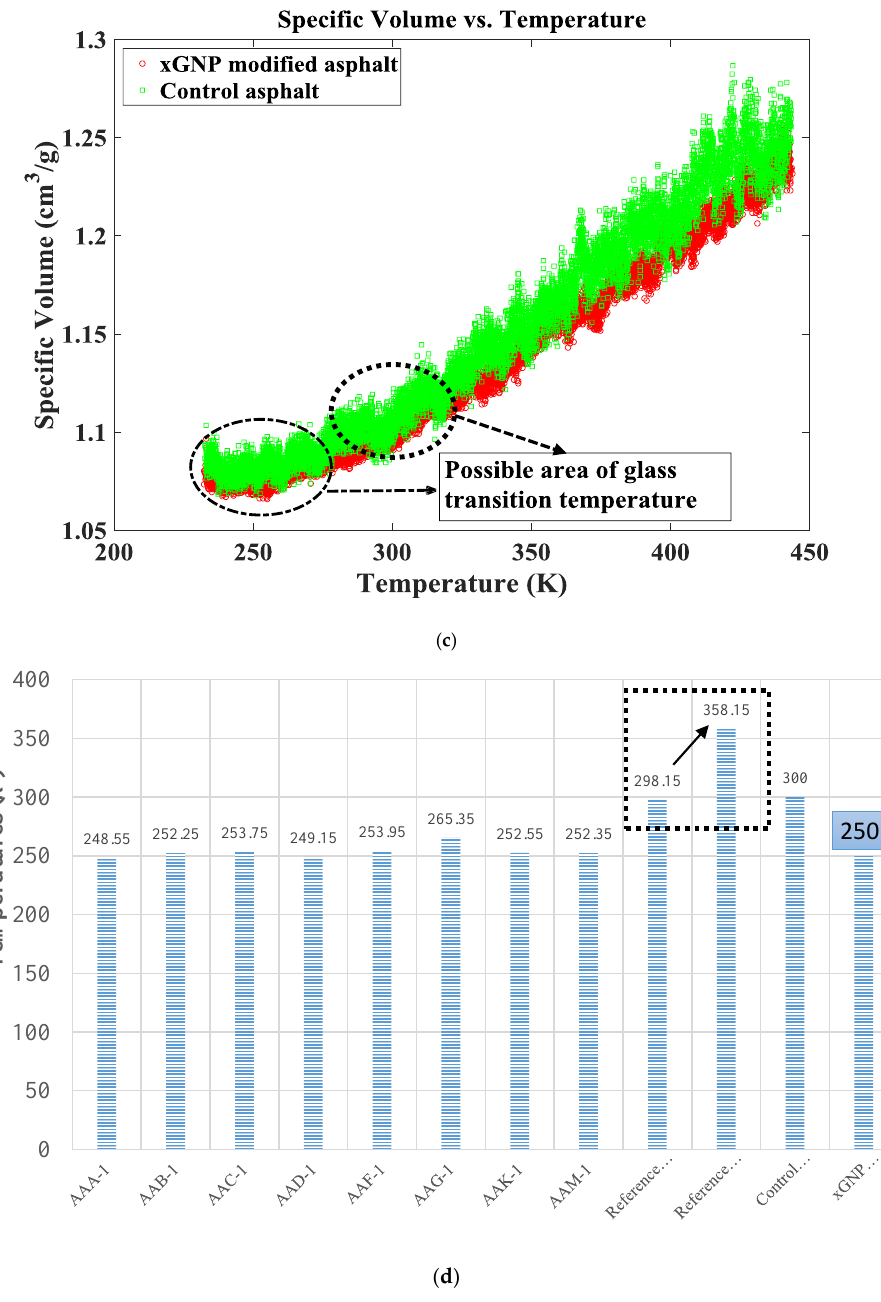
Figure 4. Specific volumes and temperatures of the control and xGNP modified asphalt systems. ( a ) specific volumes of the control asphalt system: amplified section to show the Tg temperature with asymptotes intersect for control asphalt model; ( b ) specific volumes of the xGNP modified asphalt system: amplified section to show the Tg temperature with asymptotes intersect for modified asphalt system; ( c ) specific volumes of the xGNP modified and control asphalt system; ( d ) Glass transition temperatures of different asphalt types and models: the data of the glass transition temperature of different binders is from the reference [18,24,42]: 248.55 K for AAA-1 binder, 252.25 K for AAB-1, 253.75 K for AAC-1, 249.15 K for AAD-1, 253.95 K for AAF-1, 265.35 K for AAG-1, 252.55 K for AAK-1, 252.35 K for AAM-1, which were tested by Usman (1997) [42]; 300 K for control asphalt model which is from the MD simulation by Yao at al. 2016 [24]; and temperature range from 298.15 K to 358.15 K for the reference model from MD simulation by Zhang and Greenfield [18]; Tg temperature of xGNP modified asphalt model is 250